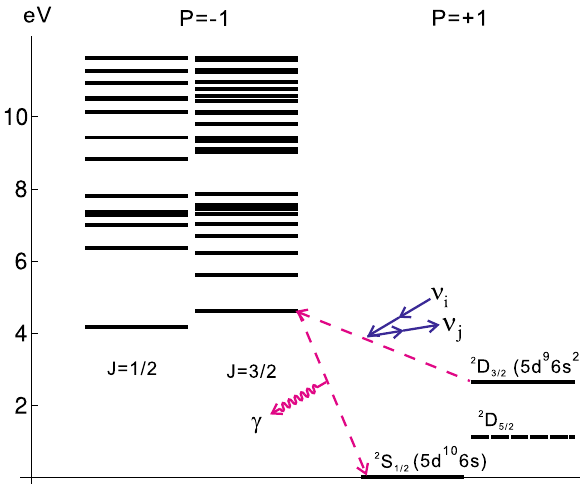
Fig. 1 Representative Au energy levels of different parities P = ± 1 for RENP for 2 D 3 / 2 → 2 S 1 / 2 + γ + ν ¯ ν . The transition occurs via various P = − 1 intermediate states; among those, 15 J = 1 / 2 and 25 J = 3 / 2 states are taken into the actual calculation. The dashed lines show an example of considered transitions, in which the transition amplitude is a product of a neutrino pair emission from | e (cid:3) = 2 D 3 / 2 to | p (cid:3) = 2 P | p (cid:3) to | g (cid:3) = 2 S 3 / 2 and an E1 radiative decay from 1 / 2